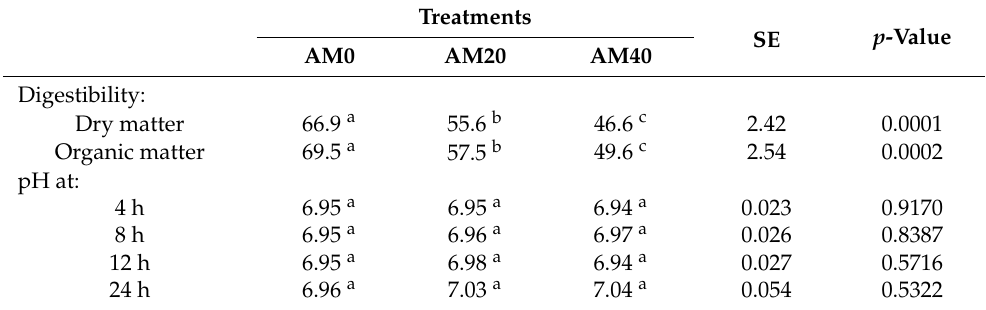
Table 3. Digestibility (%) and ruminal pH of diets with increasing levels of Acacia Mearnsii